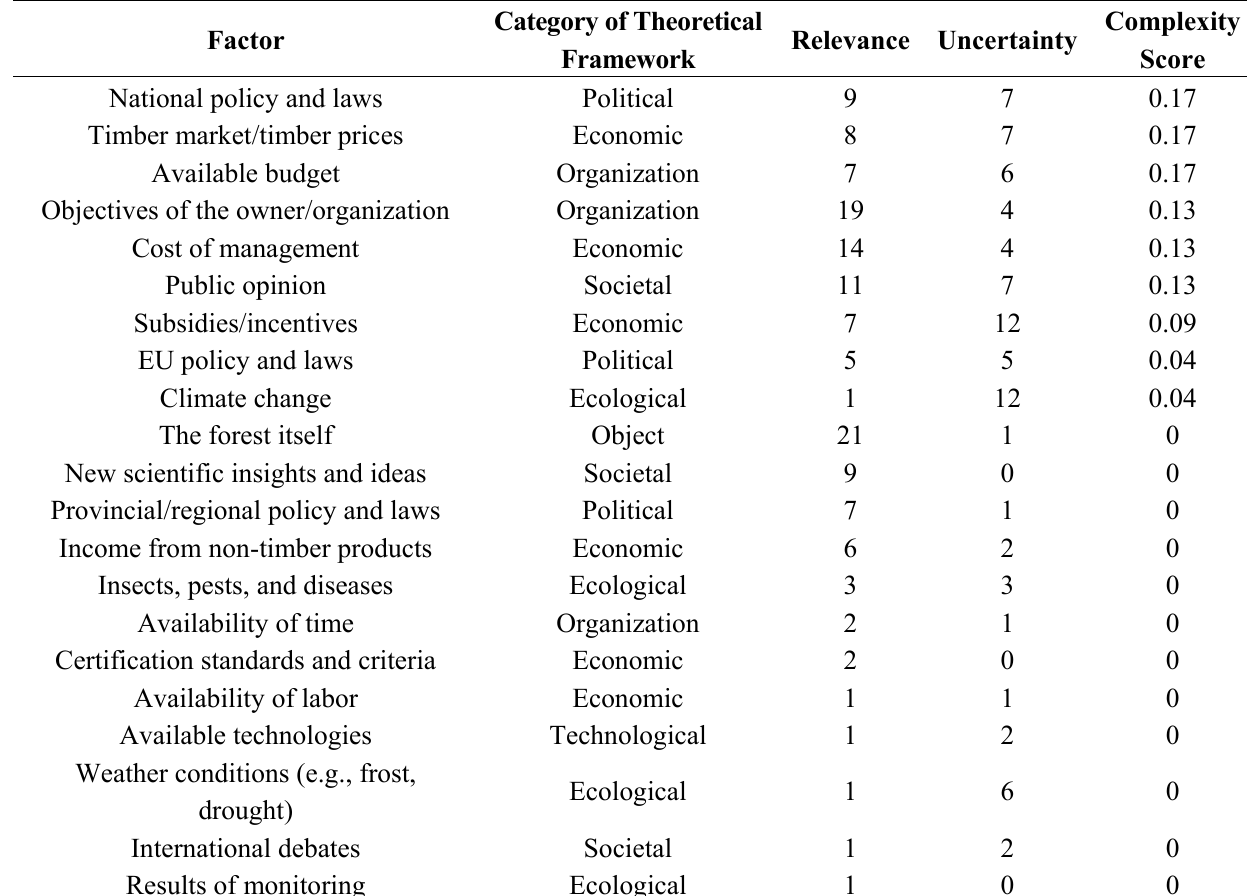
Table 3. Factors the respondents indicated in the ranking exercise ( N = 23). The category of the theoretical framework each factor is part of, the number of times it was listed as top 5, the number of times it was mentioned as uncertain, and its complexity score are